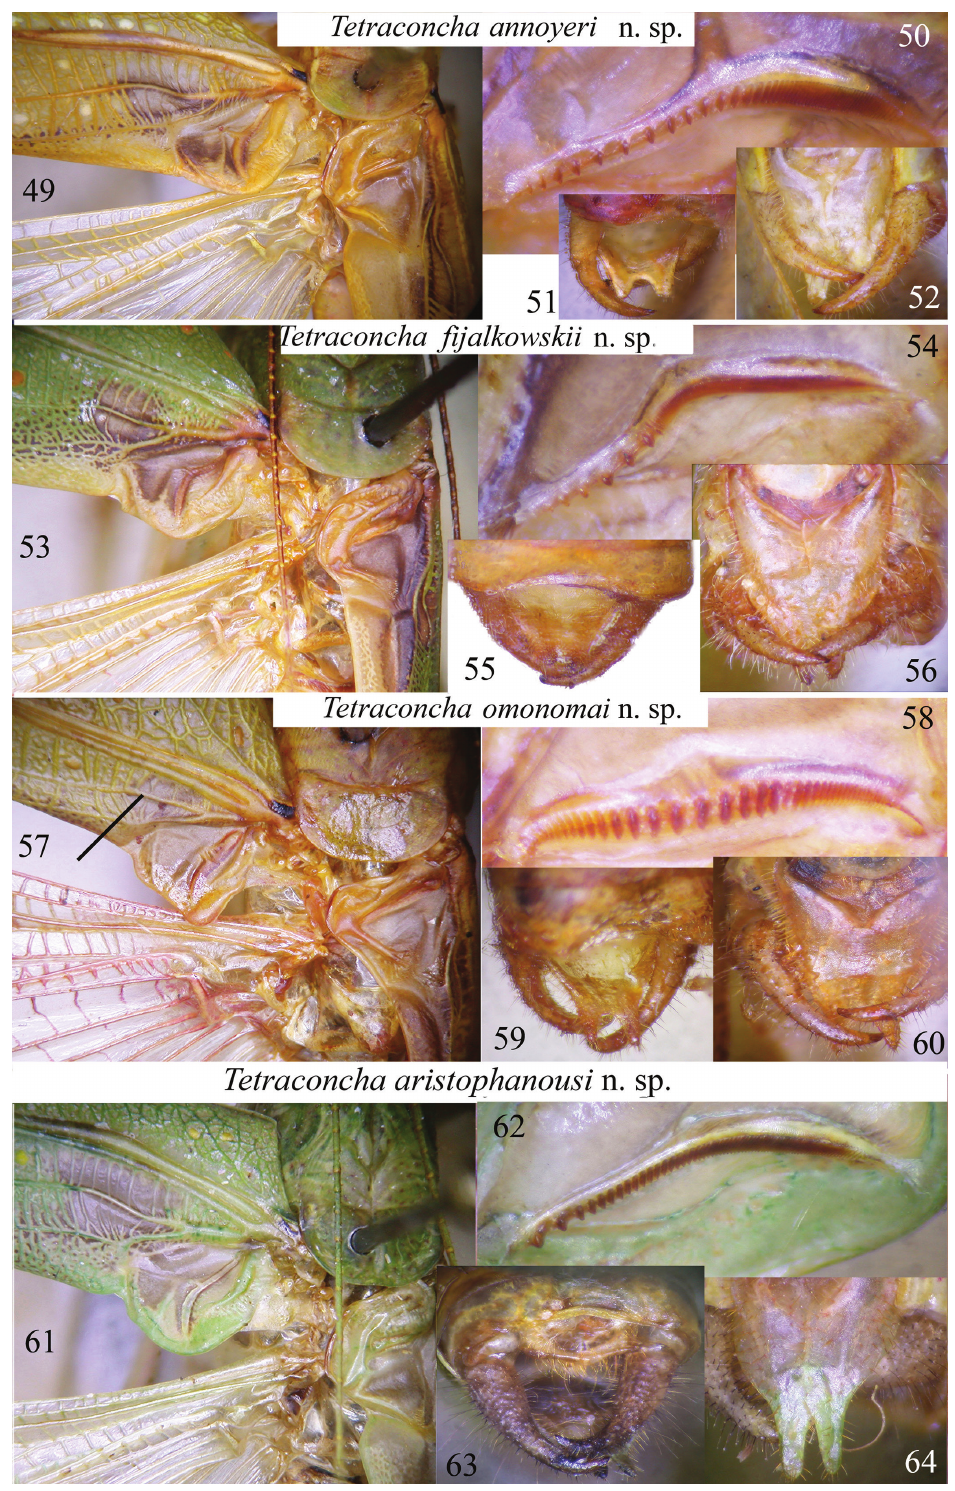
Figs 49–64. Tetraconcha annoyeri sp. n. holotype male (Central African Republic, N’Doki): 49. Stridulatory area; 50. Stridulatory file be- low the left tegmen; 51. Cerci and subgenital plate in dorsal view; 52. Cerci and subgenital plate in ventral view. Tetraconcha fijalkowskii sp. n. holotype male (Central African Republic, N’Doki): 53. Stridulatory area; 54. Stridulatory file below the left tegmen; 55. Cerci and subgenital plate in dorsal view; 56. Cerci and subgenital plate in ventral view. Tetraconcha omonomai sp. n. holotype male (Central African Republic, N’Doki): 57. Stridulatory area (the arrow shows the cubital areas); 58. Stridulatory file below the left tegmen; 59. Cerci and subgenital plate in dorsal view; 60. Cerci and subgenital plate in ventral view. Tetraconcha aristophanousi sp. n. holotype male (Ivory Coast, Taï Nat. Park): 61. Stridulatory area; 62. Stridulatory file below the left tegmen; 63. Cerci and subgenital plate in dorsal view; 64. Cerci and subgenital plate in ventral